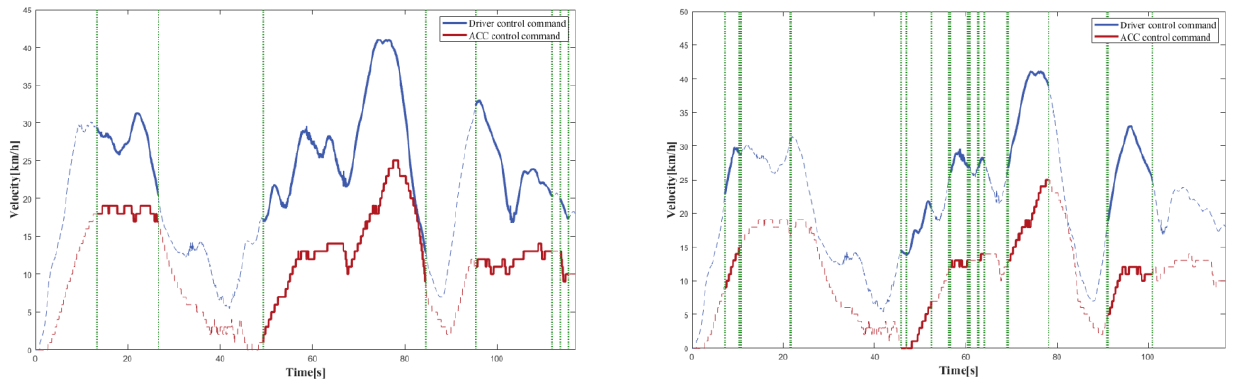
Figure 10. Distance matrix and warping path visualization for the 1st round test.